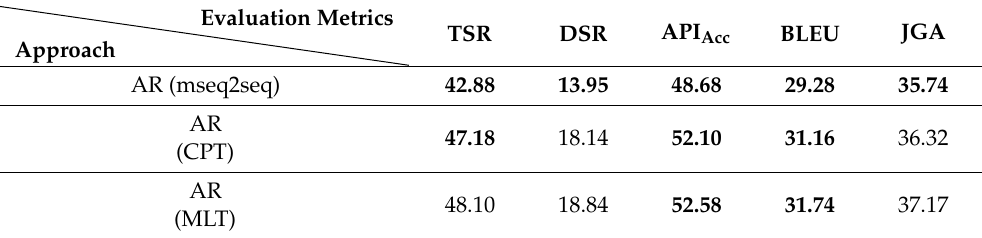
Table 3. Three approaches in cross-lingual settings results of DST and end-to-end dialogue generation with all the Arabic-TOD dataset. Numbers in bold font indicate superior corresponding values to the Chinese model that were mentioned in Table